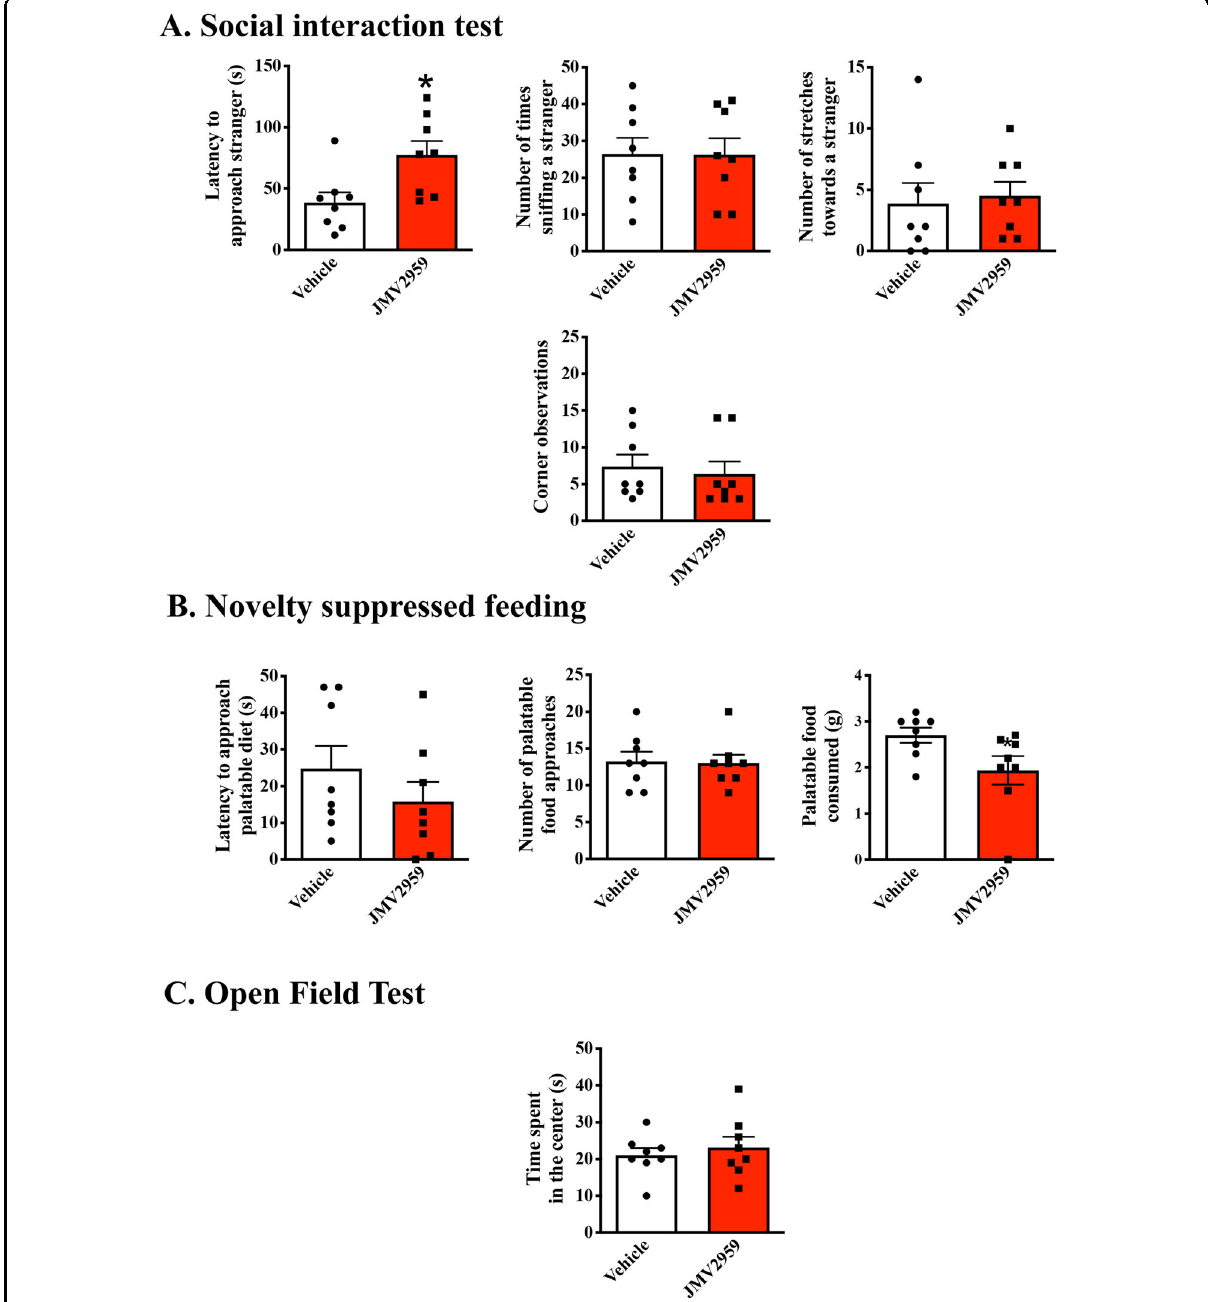
Fig. 2 Behavioral responses of mice receiving peripheral injections of the GHSR antagonist JMV2959 (3 mg/kg) ( n = 8) or saline ( n = 8). As seen in panel A , peripheral injections of JMV2959 resulted in increased latencies to approach a novel mouse ( p < 0.05). Treatment with the GHSR antagonist did not affect the latency to approach a palatable snack compared to control mice but it did decrease the amount of food consumed by these mice once they approached the food ( p < 0.05); see Panel B ). Finally, peripheral JMV2959 treatment did not affect behavior in the open fi eld test (see Panel C ). * p <